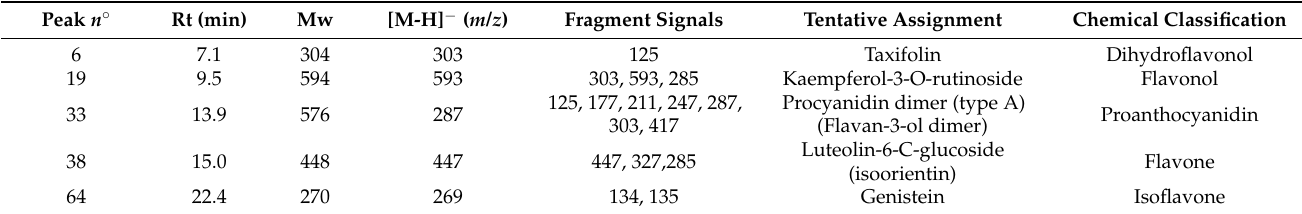
Table 1. Major phytochemical compounds identified in the heartwood extract